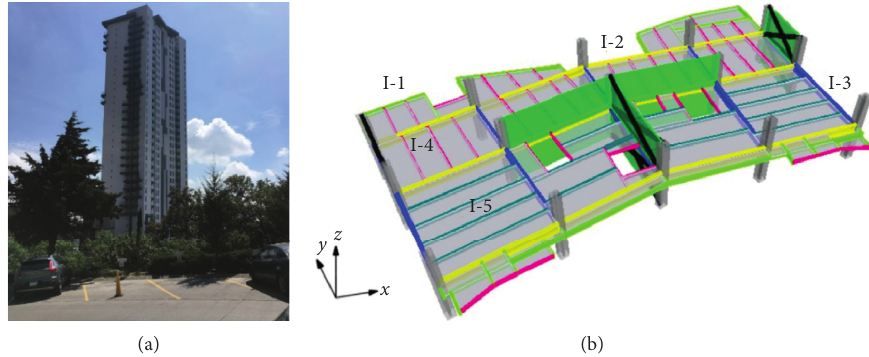
Figure 6: 144-meter-tall building located in the Valley of Mexico [55]. (a) General view. (b) Floor system.